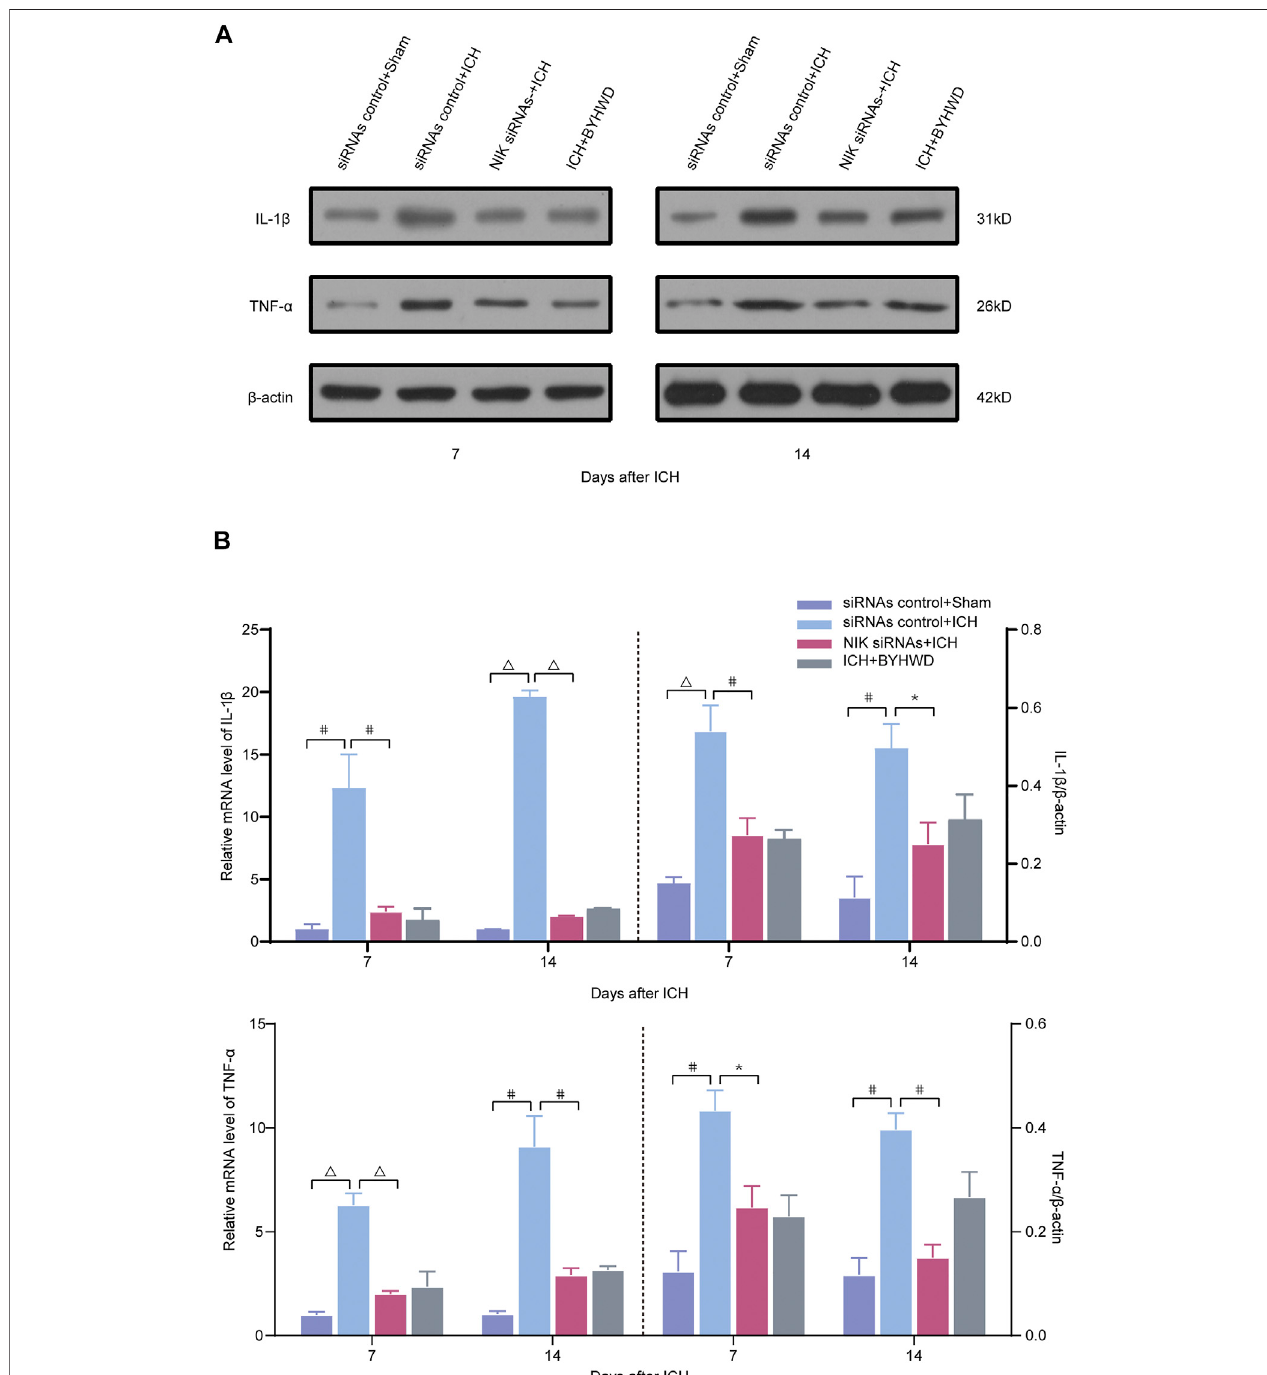
FIGURE5 | Downregulatedthein fl ammatoryfactorsTNF- α andIL-1 β followingICH via transfectedwithNIKsiRNAsscreening.RelativeexpressionsofTNF- α andIL-1 β were measuredondays7and14transfectedwithNIKsiRNAsorsiRNAscontrolafterICH.ArepresentativeimmunoblotshowedtheeffectsofsiRNAscontrol+Sham,siRNAscontrol+ ICH, NIK siRNAs + ICH, and ICH + BYHWD on the protein levels of in fl ammatory factors TNF- α and IL-1 β (A) at the ipsilateral injury area. The left side of the dotted line shows the relativemRNAlevelsofTNF- α andIL-1 β (B) ,respectively.TherightsideofthedottedlineshowstheproteinlevelsofTNF- α andIL-1 β (B) ,respectively.LevelsofTNF- α andIL-1 β mRNAsweredramaticallydecreasedintheNIKsiRNAs+ICHandtheICH+BYHWDgroupafterICH.WesternblotanalysisshowedthattheexpressionlevelsofTNF- α andIL-1 β weresigni fi cantlydownregulatedafterICH.EffectofBYHWDtreatmentisconsistentwiththeeffectofblockingNIKtransfectedwithNIKsiRNAs.BYHWDsuppressedin fl ammatory response.RelativeTNF- α andIL-1 β levelswerecalculatedbasedondensitometryanalysis.ThemeanTNF- α andIL-1 β leveloftheshamgroupwasnormalizedto1.0.Dataarethe mean ± SEM ( n (cid:2) 3 each group); * p < 0.05, # p < 0.01, Δ P < 0.001 deemed as signi fi cant difference.